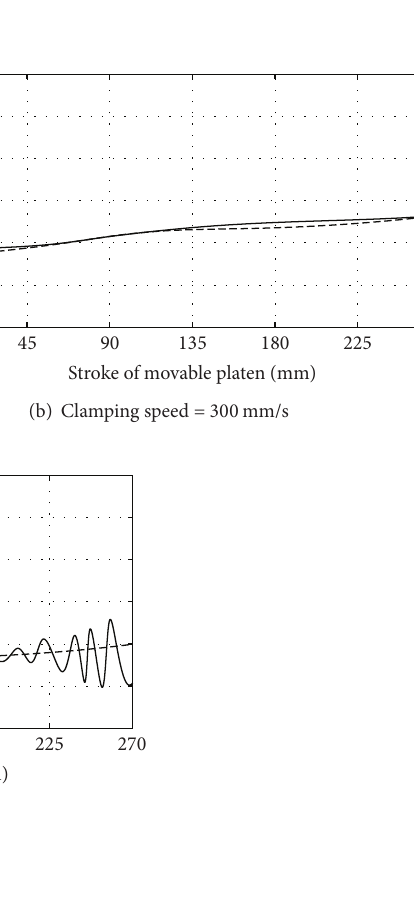
Figure 9: Vibrating displacement of D point in 𝑌 direction at different clamping speed.